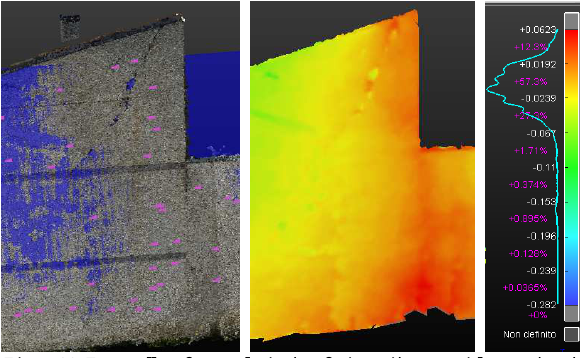
Figure 20. East wall surface analysis: data fusion with terrestrial